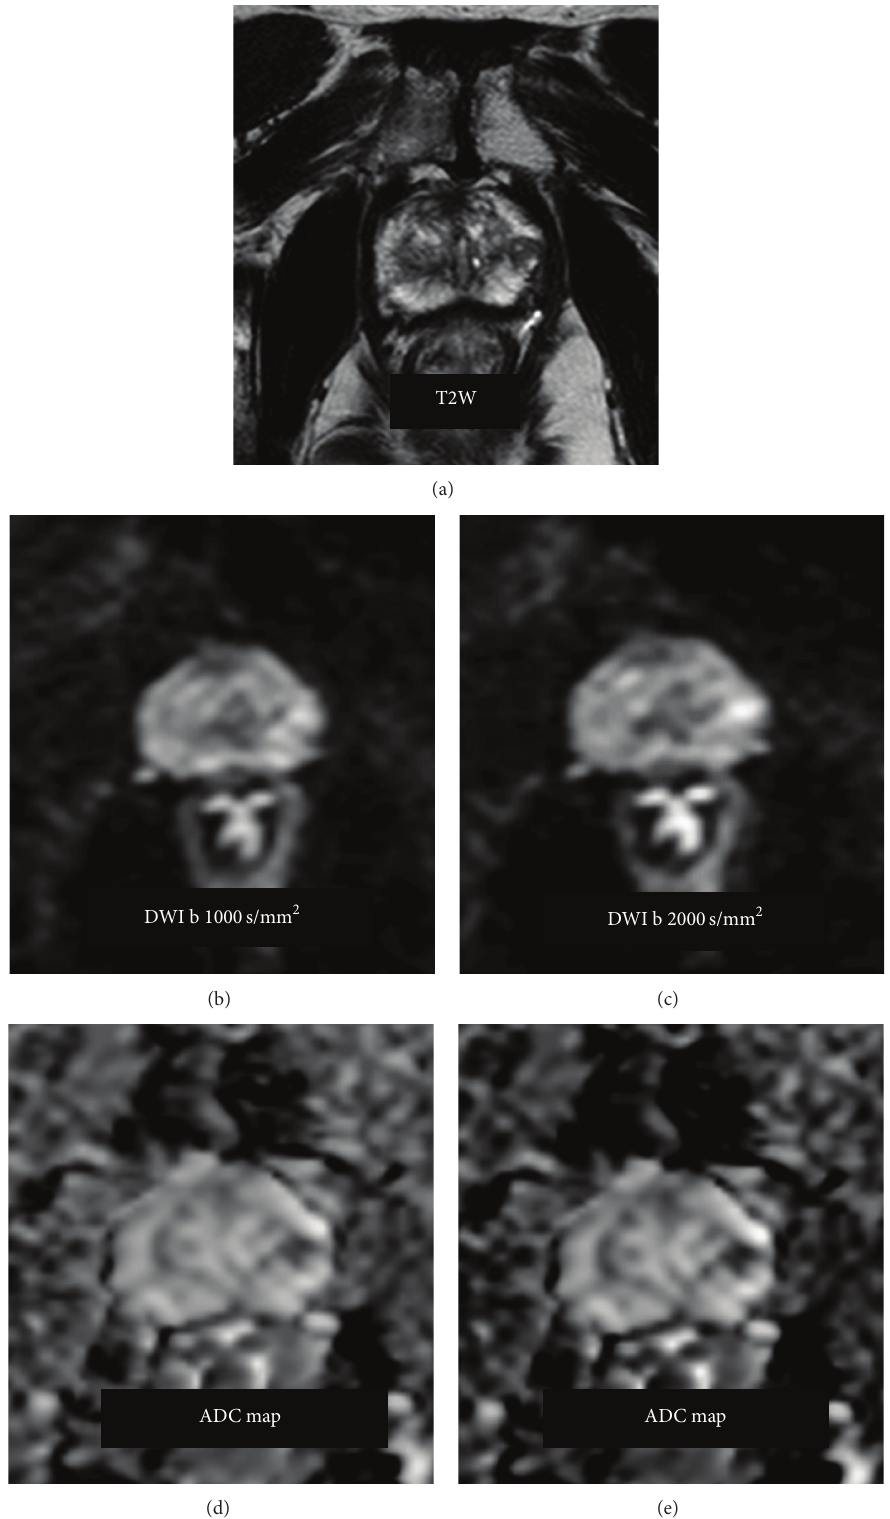
Figure 2: A69-year-old man with prostatecancer Gleason 3 +4. (a)T2-weighted image showsa hypointense focal area on left midgland in the peripheral zone. (b) DWI with 𝑏 -value of 1000 s/mm 2 shows a slight focal increased signal in the left peripheral zone almost indistinguishable compared to surrounding benign tissue. (c) DWI 𝑏 -value of 2000 s/mm 2 ; the tumor is easily identifiable compared to the benign tissue. ((d) and (e)) ADC maps obtained with 𝑏 -values of 0–1000 s/mm 2 (d) and 0–2000 s/mm 2 (e) show the tumor as a focal area of decreased signal intensity on the left midgland in the peripheral